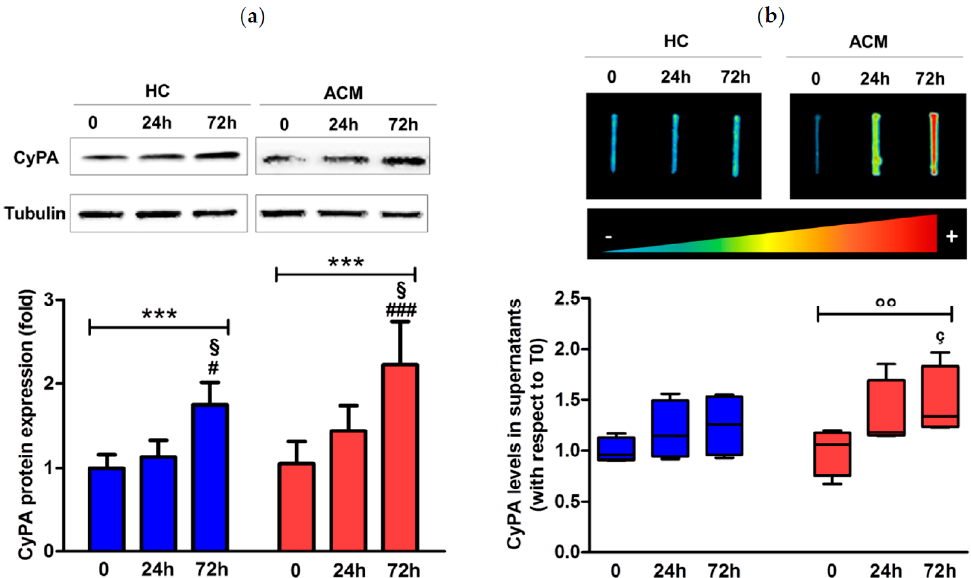
Figure 5. CyPA protein expression levels in cell lysates ( a ) and supernatants ( b ) of HC and ACM C-MSC cultured in adipogenic condition for 72 h. *** p value ≤ 0.001 at two-way ANOVA and § p value ≤ 0.05 vs. “24 h”, # p value ≤ 0.05 vs. “0”, ### p value ≤ 0.001 vs. “0” at Bonferroni post-test. °° p value ≤ 0.01 at Friedman test, and ç p value ≤ 0.05 vs. “0” at Dunn’s Multiple Comparison post-test.